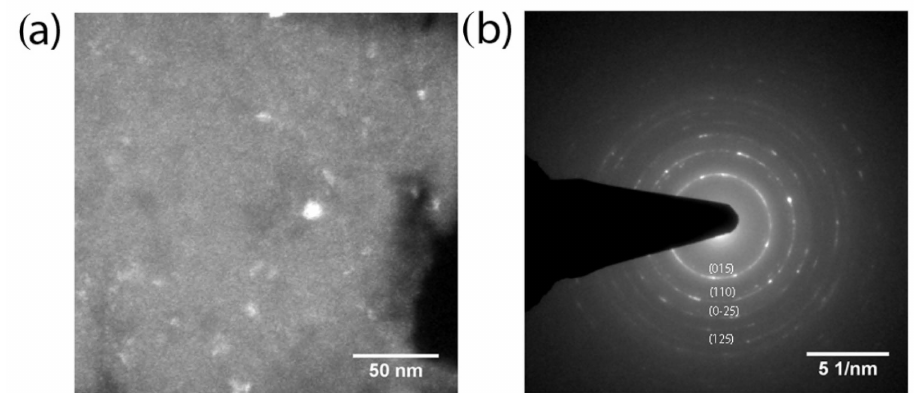
Figure 4. ( a ) A dark field TEM plan view image. Crystalline grains in Bragg position appear bright. ( b ) Diffraction pattern of the area in the left